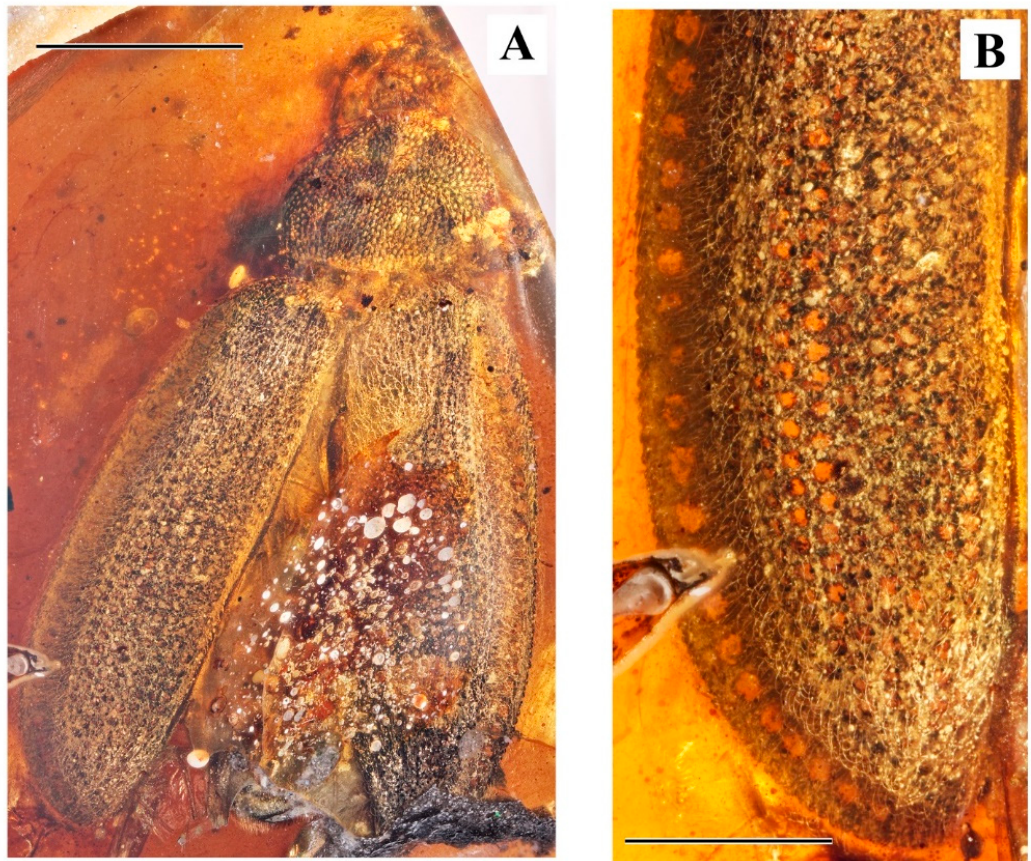
Figure 17. Ommatinae (Cupedidae): Polyakius pubescens sp. nov. , holotype ZIN Cuped 003